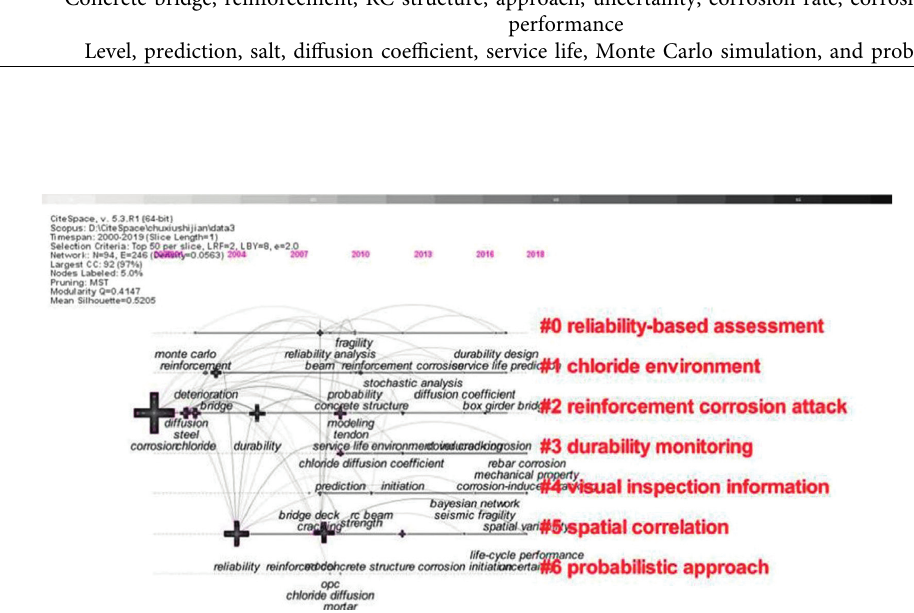
Figure 9: Timeline view of keyword on predicting the time to corrosion